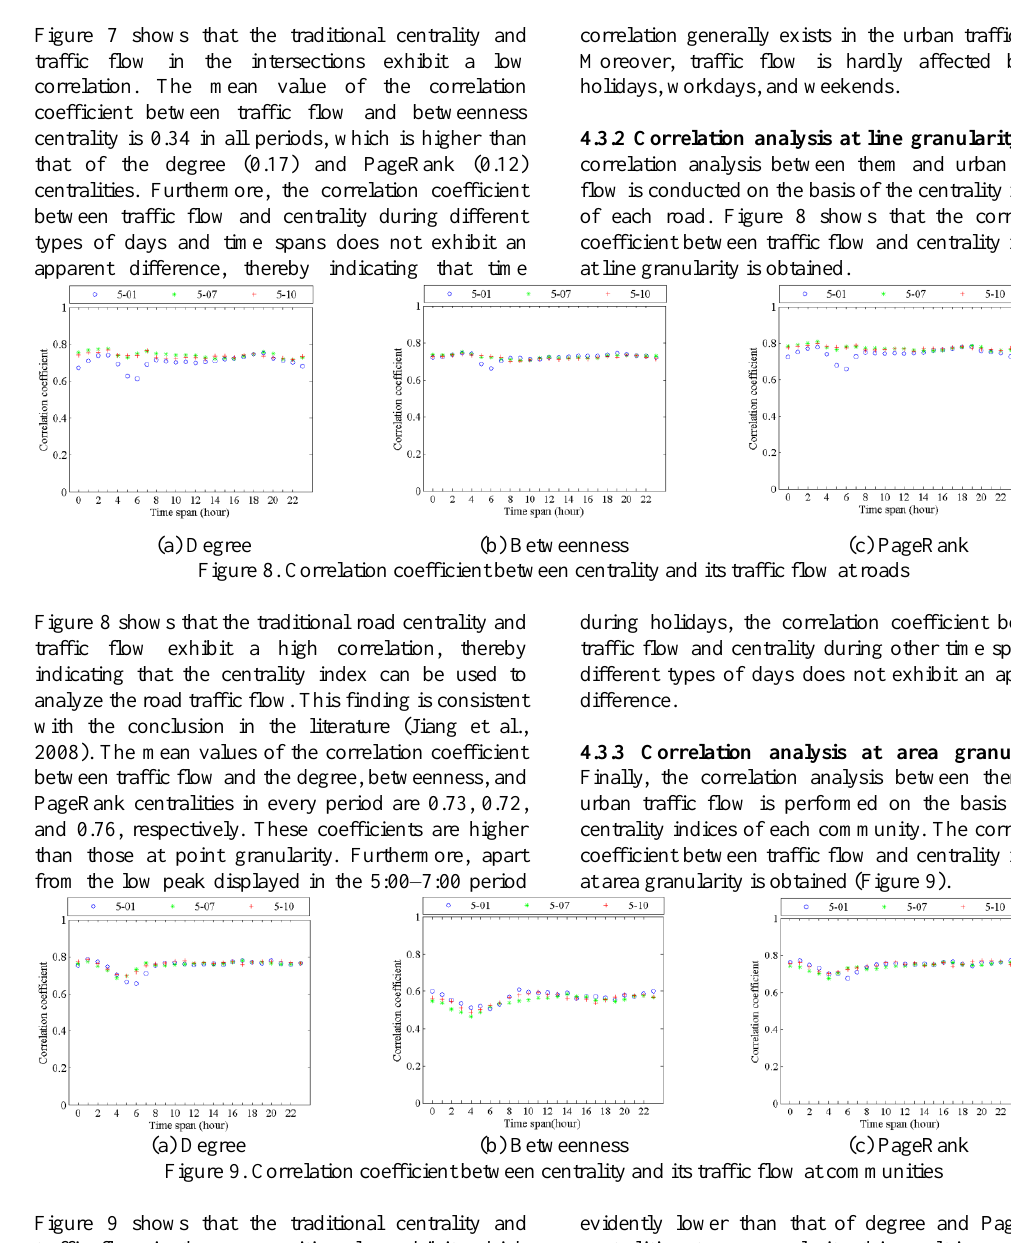
Figure 7. Correlation coefficient between centrality and traffic flow at intersections